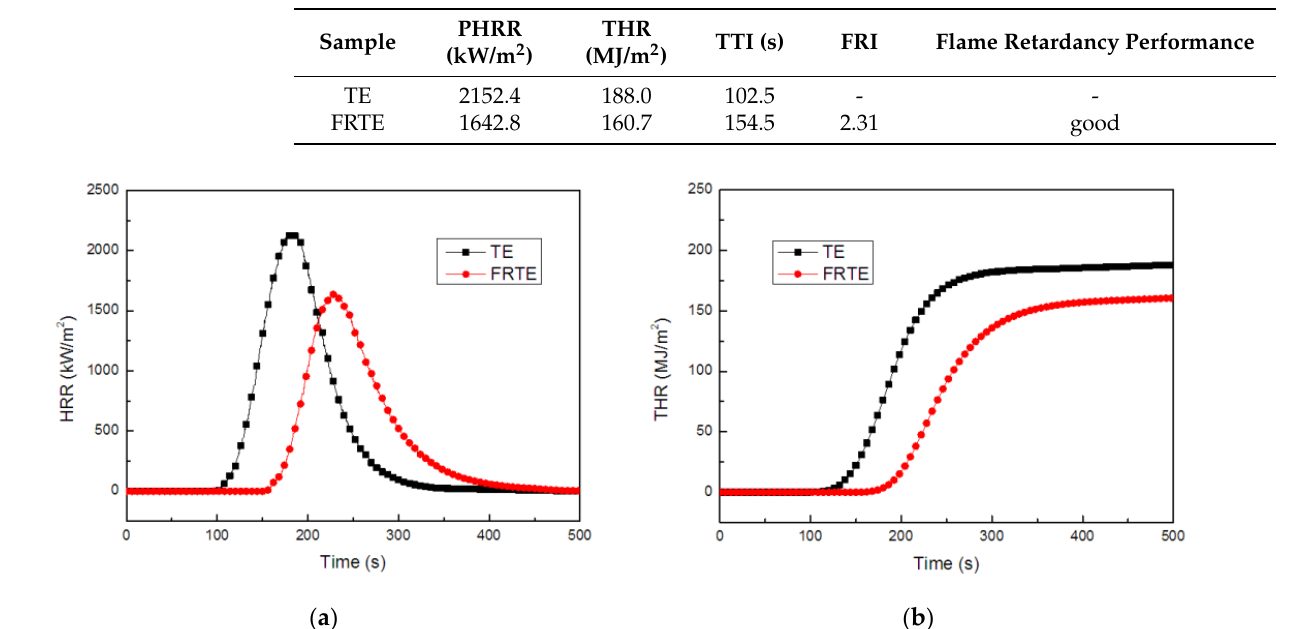
Figure 2. HRR ( a ) and THR ( b ) curves of TE composites.